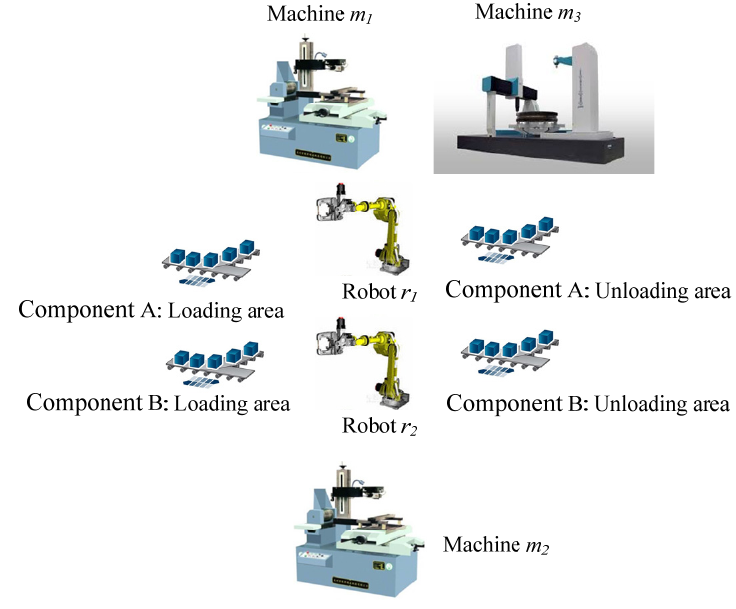
Figure 8. The automated manufacturing system in [21,24].